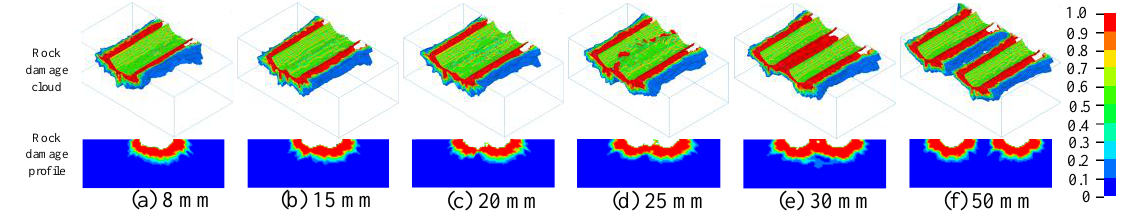
Figure 20. The rock damage cloud of the distances between double conical picks.